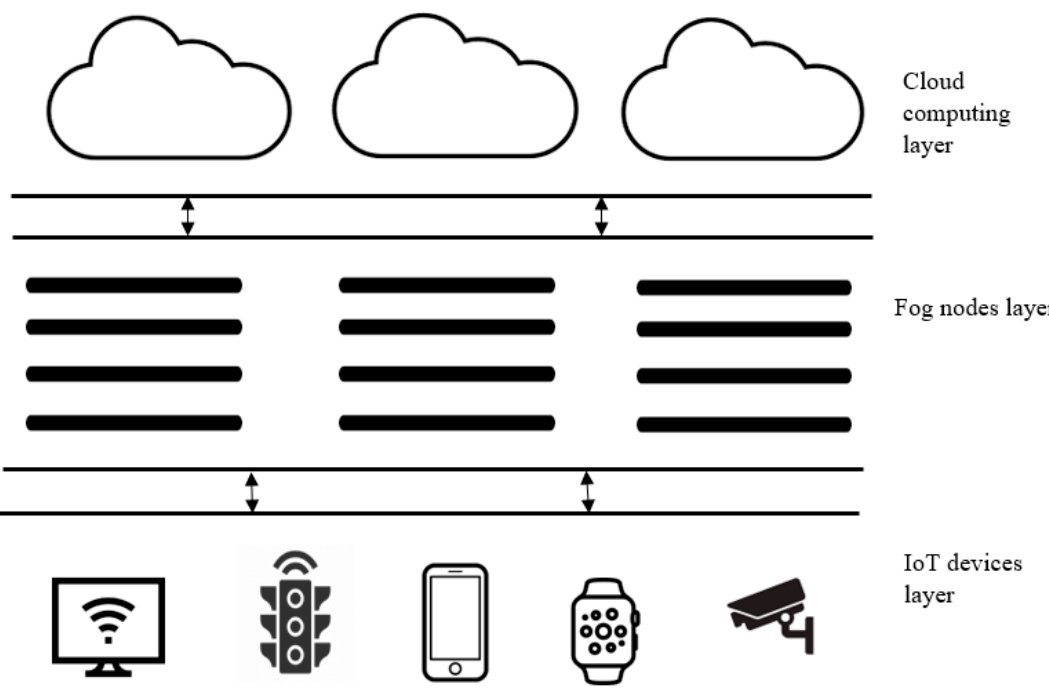
Figure 1. Fog computing architecture.